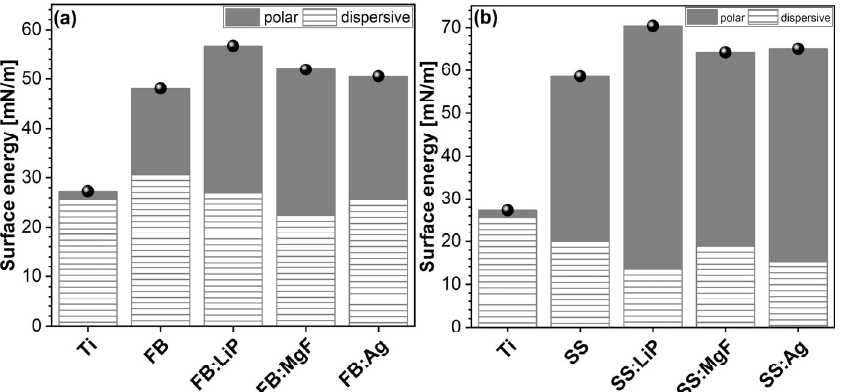
Figure 6. The values of the surface free energy calculated for Ti and simple and doped FB ( a ) and SS ( b ) thin fi lms ( γ d —hatched region, γ p —grey region). SS ( b ) thin films ( γ d —hatched region, γ p —grey region).